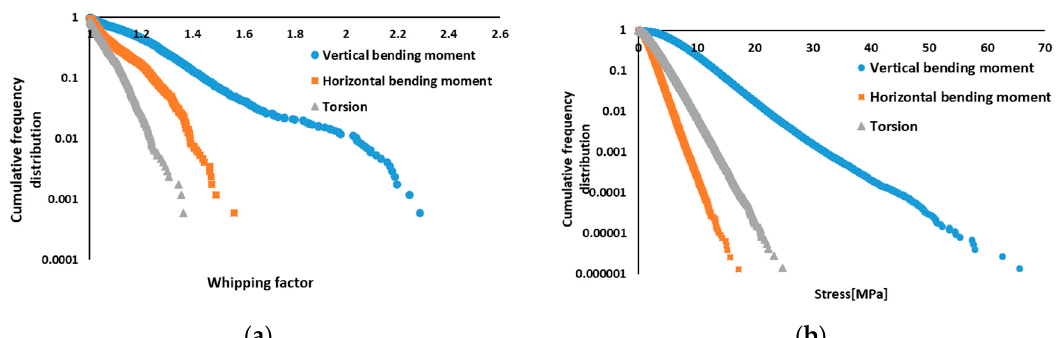
Figure 7. ( a ) Cumulative frequency distribution of whipping factor (H 1/3 > = 3.0 m), ( b ) exceedance probability distribution of longitudinal stress (H 1/3 > = 3.0 m).